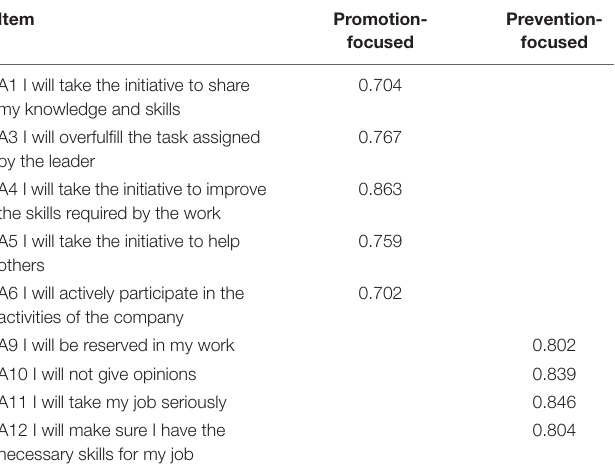
TABLE 2 | Exploratory factor analysis results ( N =